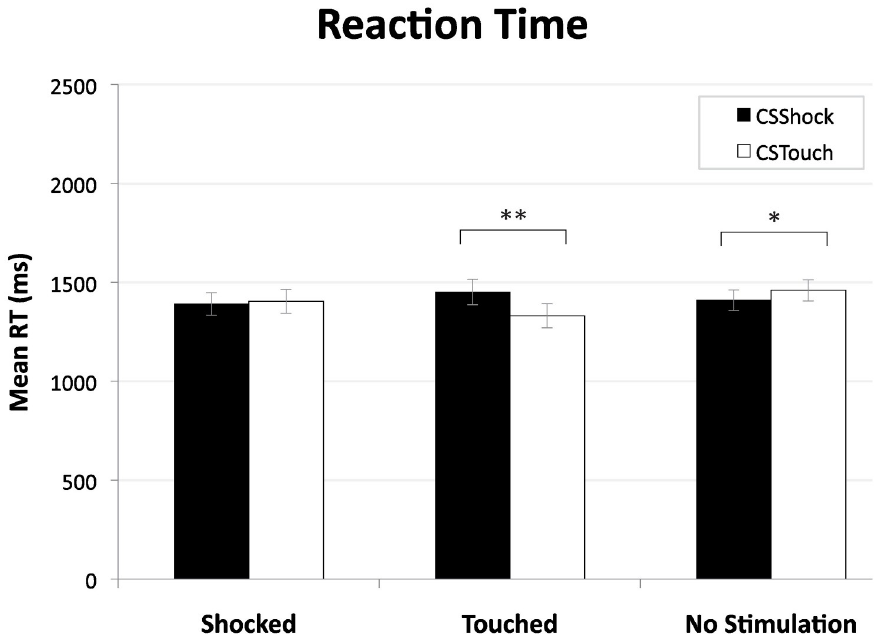
Fig 4. Mean reaction time (in ms) for CS Shock - and CS Touch -trials as a function of reminder (i.e., proceeding a trial in which a Shock, a Touch, or no electro stimulation was given). Error bars depict standard error of the mean. Note . � p < .05, �� p <